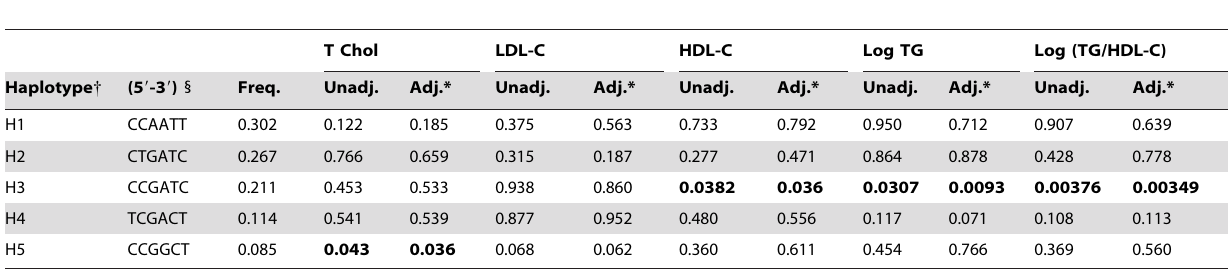
Table 6. Association between CNR1 haplotype and median lipid traits (p-values are shown, calculated using a linear regression model in PLINK).